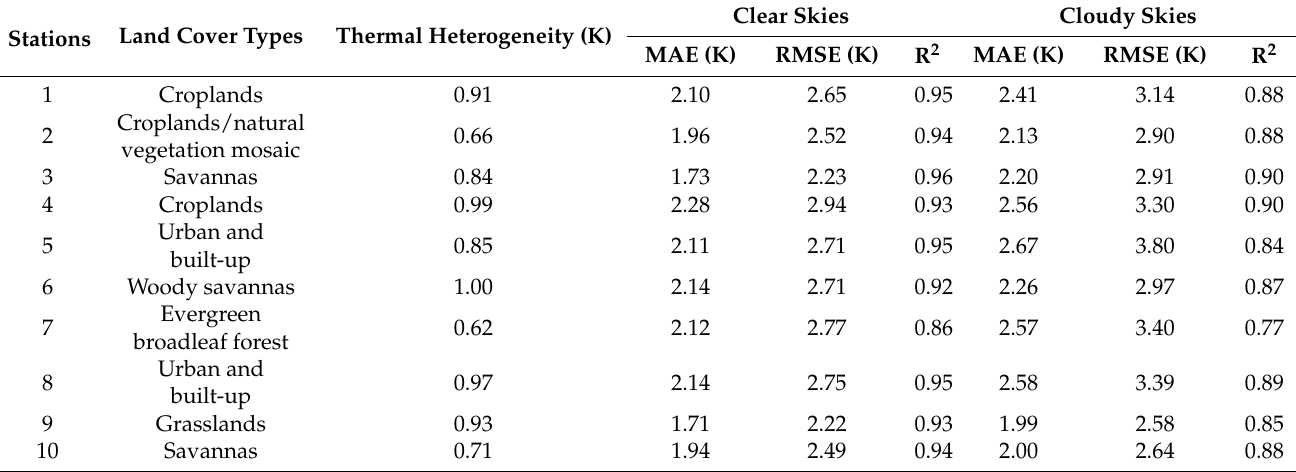
Table 3. The comparisons of the MLP-GTWR LST cor under clear-sky and cloudy-sky conditions against the 0-cm temperature at ten automatic meteorological stations. The thermal heterogeneity is the mean standard deviation (STD) of all sub-pixel Landsat 30-m LST within a 1-km MODIS pixel. Refer to Figure 1b for numbers of the station